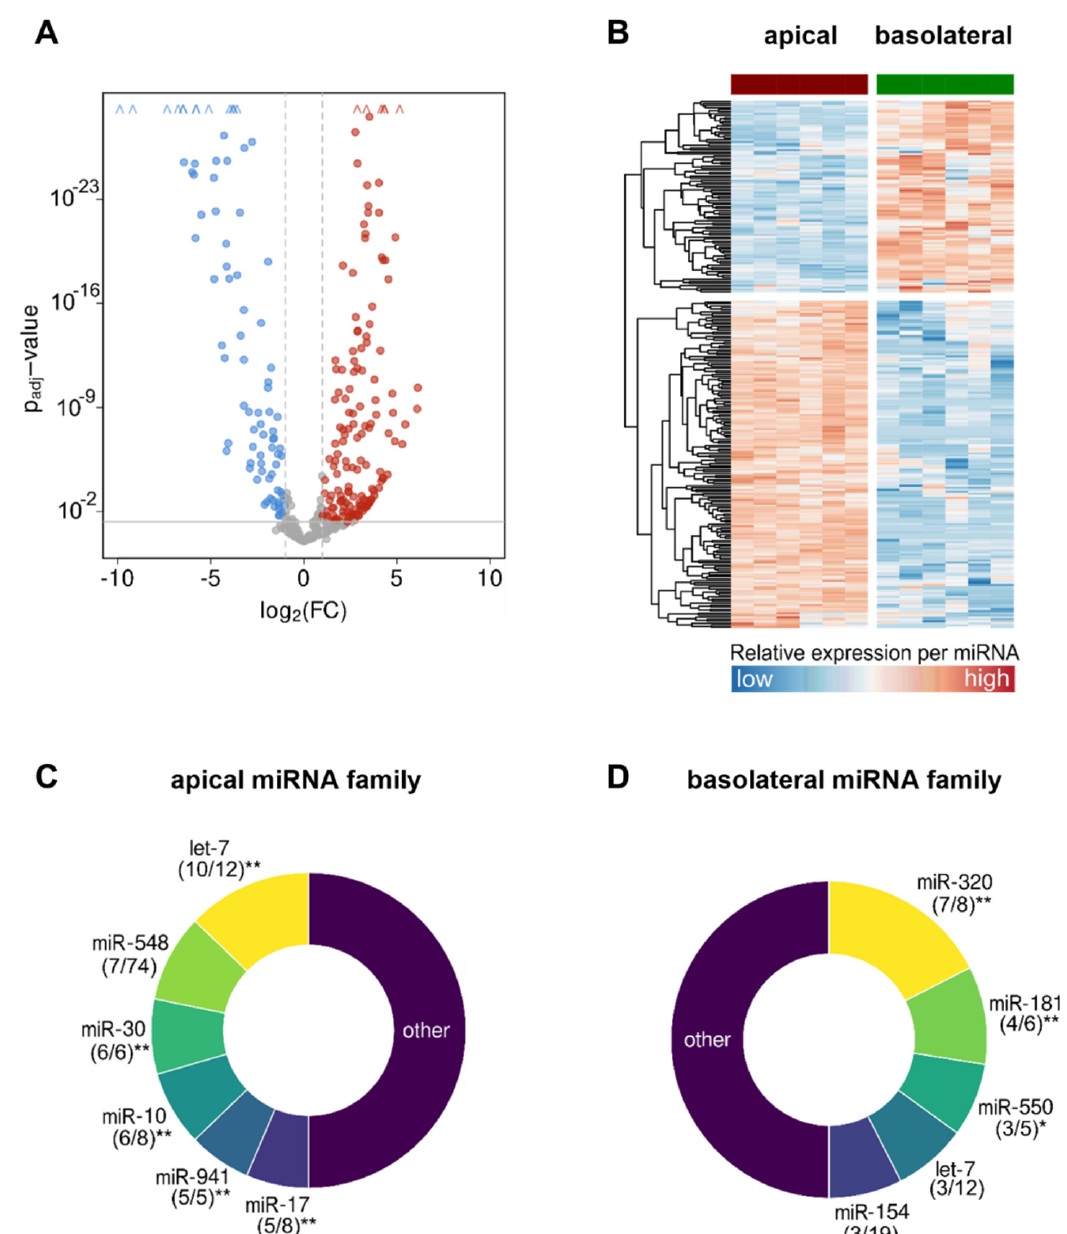
Figure 5. Differential expression analysis of vesicular miRNAs in apical versus basolateral compart- ments of bronchial epithelial cell cultures. ( A , B ) Volcano plot and heat map showing the differentially expressed miRNAs within EVs secreted to the apical versus basolateral compartment at p adj < 0.05 and FC ≥ 2, and ( C , D ) donut charts showing the distribution of the mainly represented miRNA families in both compartments. Digits in brackets depict the number of enriched miRNA family members out of the total number of miRNAs belonging to the respective family, * p < 0.05, ** p < 0.01, miRNA—microRNA; EV—extracellular vesicle; FC—fold change.